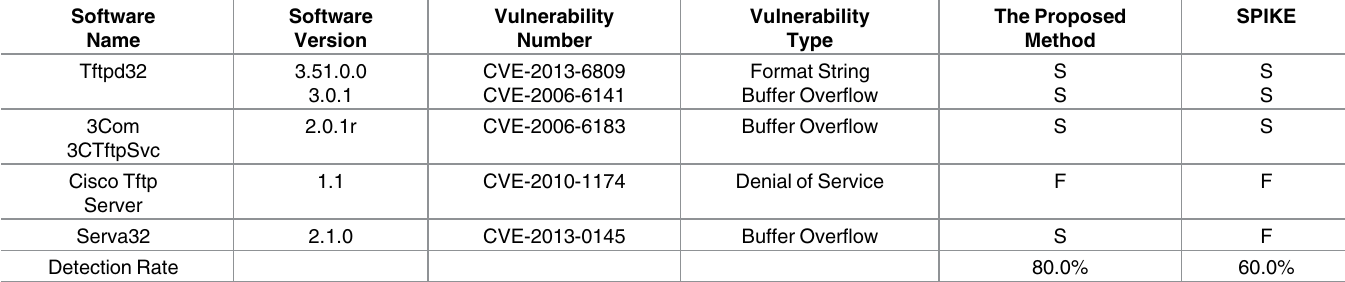
Table 5. Comparison of the proposed method and SPIKE in vulnerability detection with TFTP protocol programs. Software Name